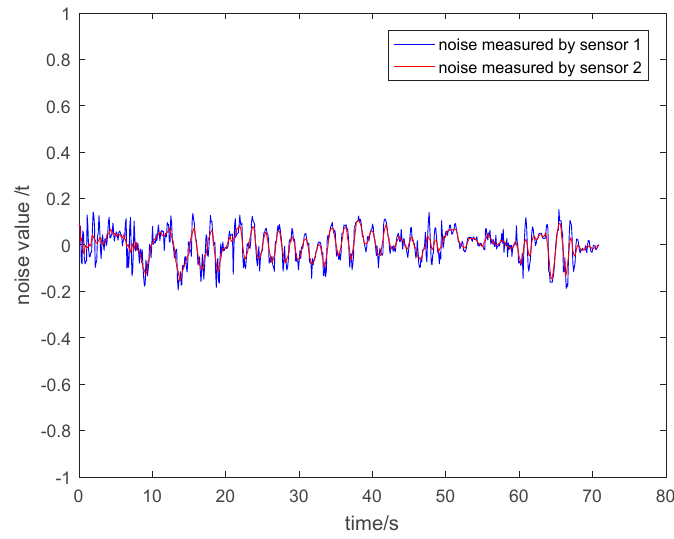
Figure 30. Noise value curves during lifting process of cage without load.